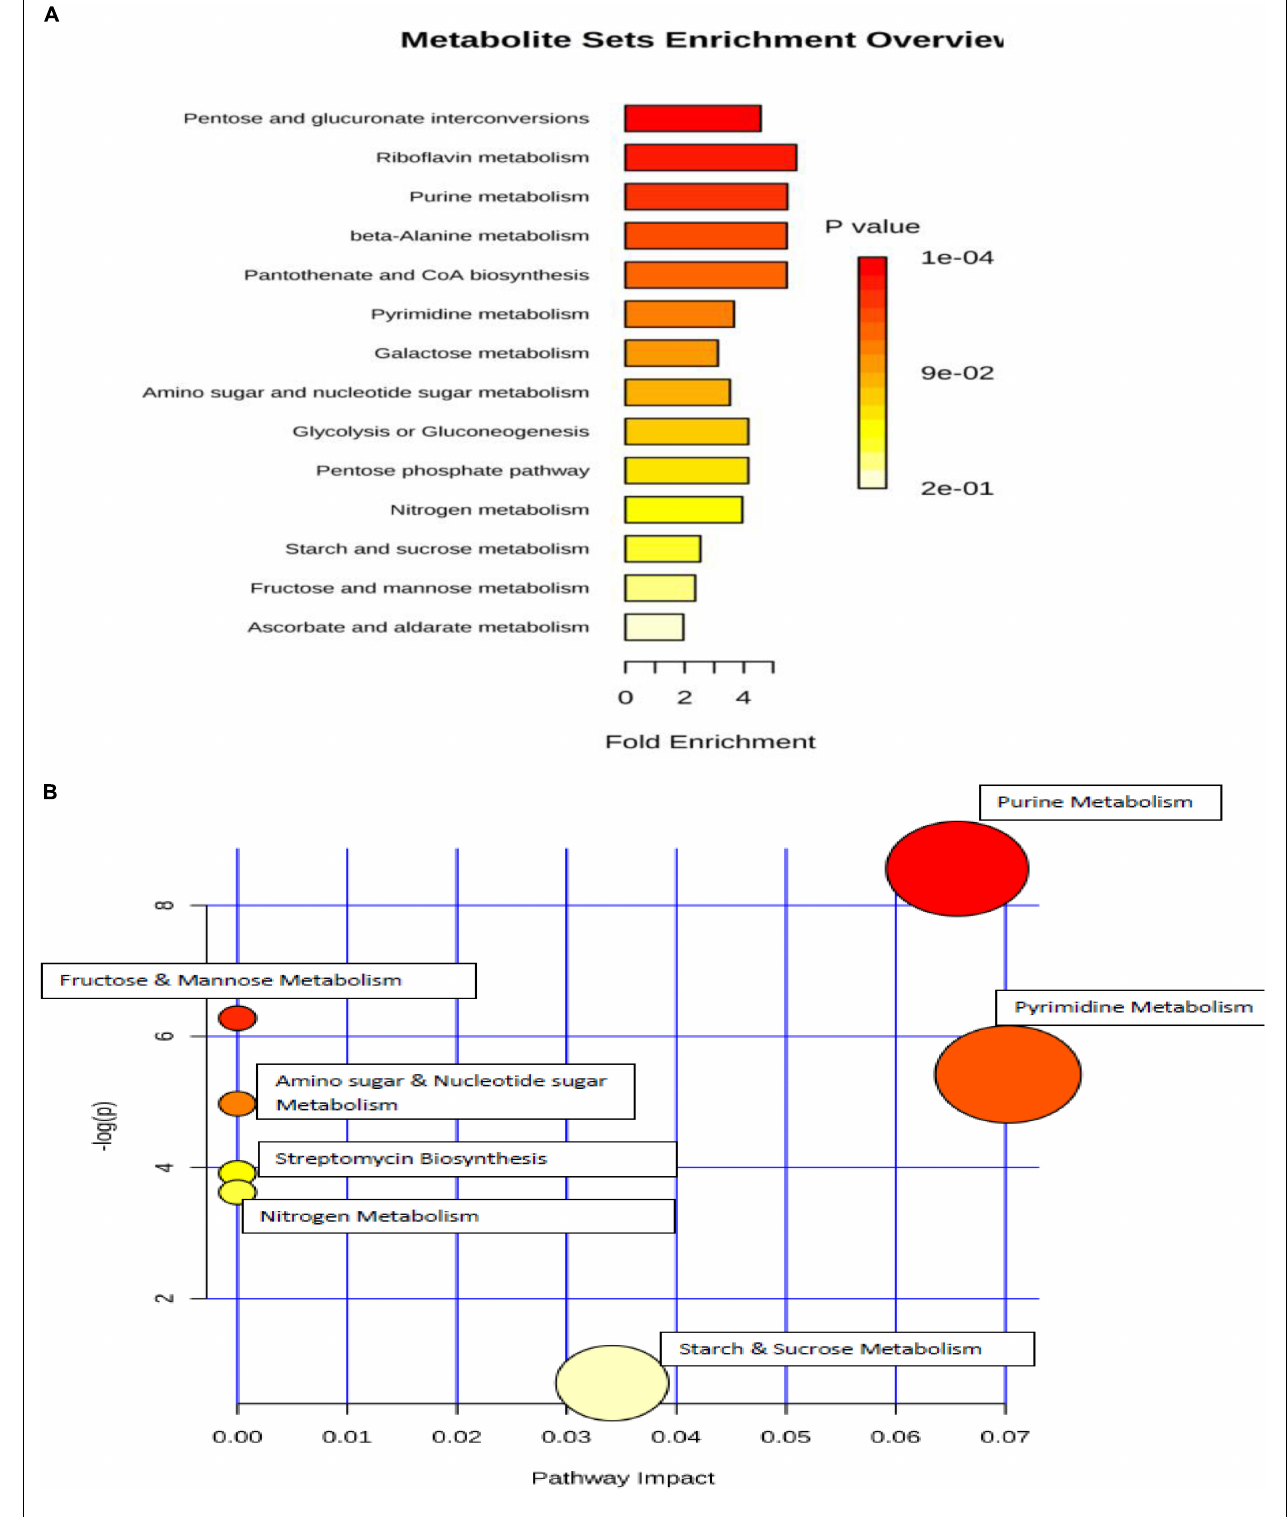
FIGURE 8 | (A) metabolic set enrichment using metabolite concentrations showing the most altered pathways in elevated NaCl (5%). (B) pathway impact analysis. All the matched pathways are shown as circles. The color and size of each circle is based on p -value and pathway impact value, respectively. Colors of the circle based on p -values. The darker colors indicate more significant changes of the pathways ( p < 0.05 ).